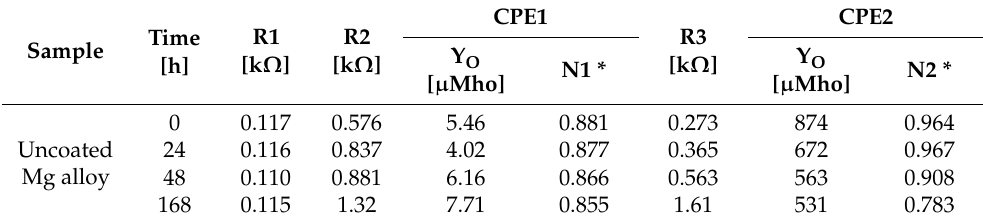
Figure 5. Nyquist ( a ), Bode ( b ) diagrams, and ( c ) equivalent circuit from 0–168 h of uncoated Mg alloy, immersed in SBF. Table 5. Values from equivalent circuit uncoated Mg alloy.